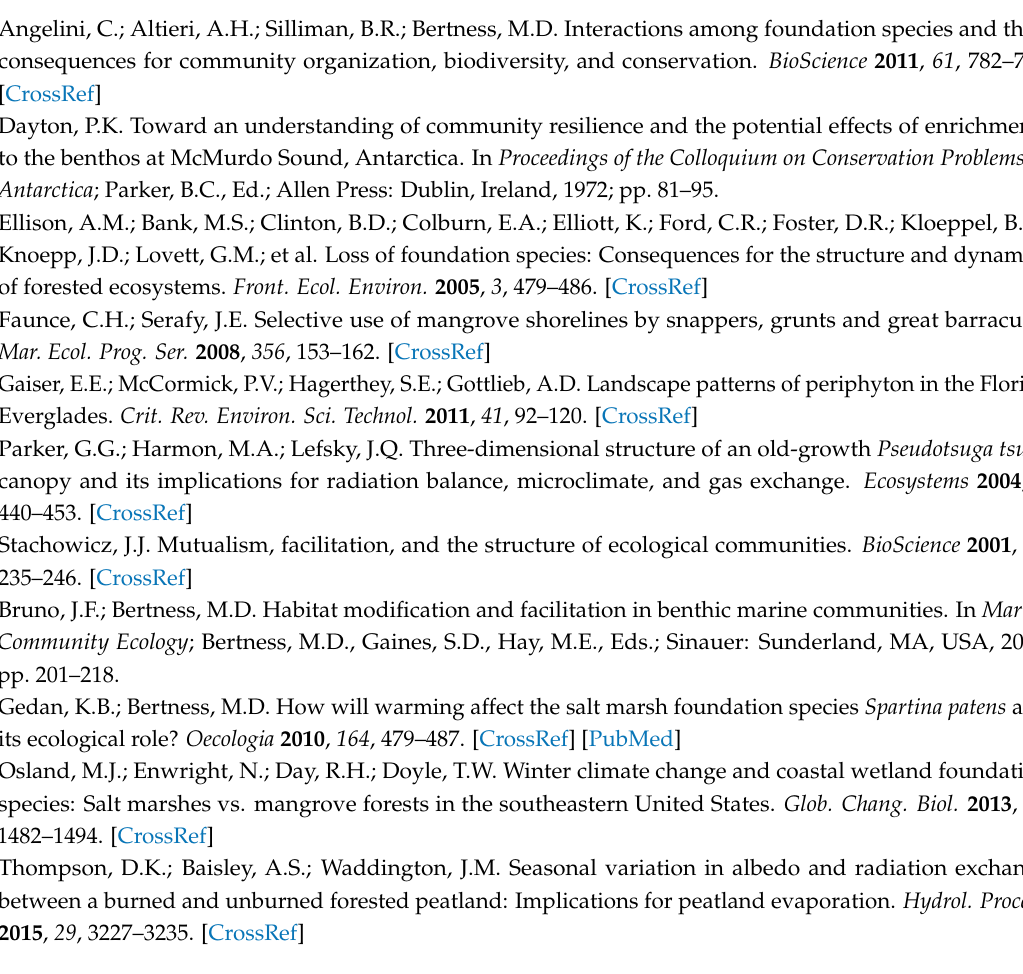
Table S1: Publications used for the literature review (references only cited in the introduction and